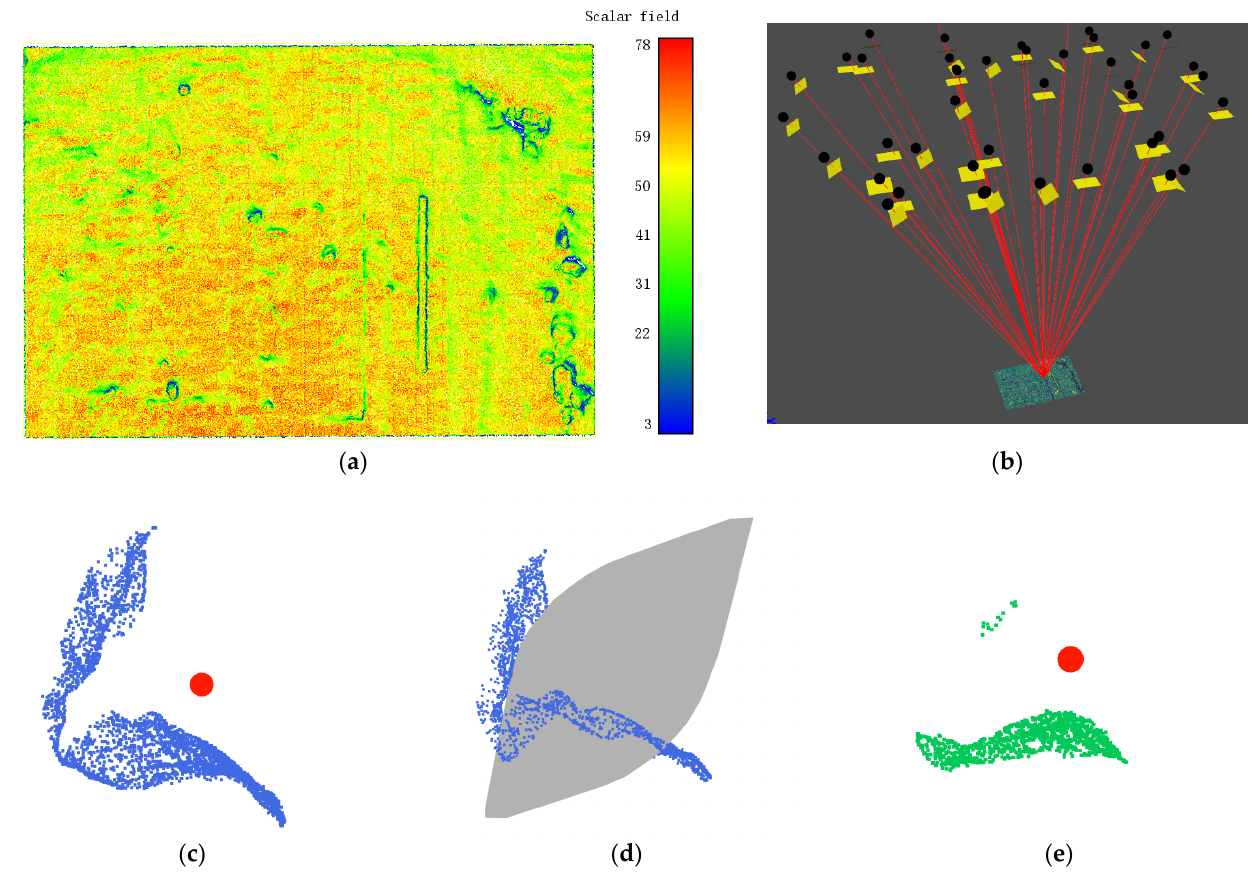
Figure 9. Error space estimation and neighboring points searching and filtering. ( a ) Distribution of number of visible cameras; ( b ) ray tracing for visibility check; ( c ) kNN search result; ( d ) intersection with error space; ( e ) filtered neighboring points.